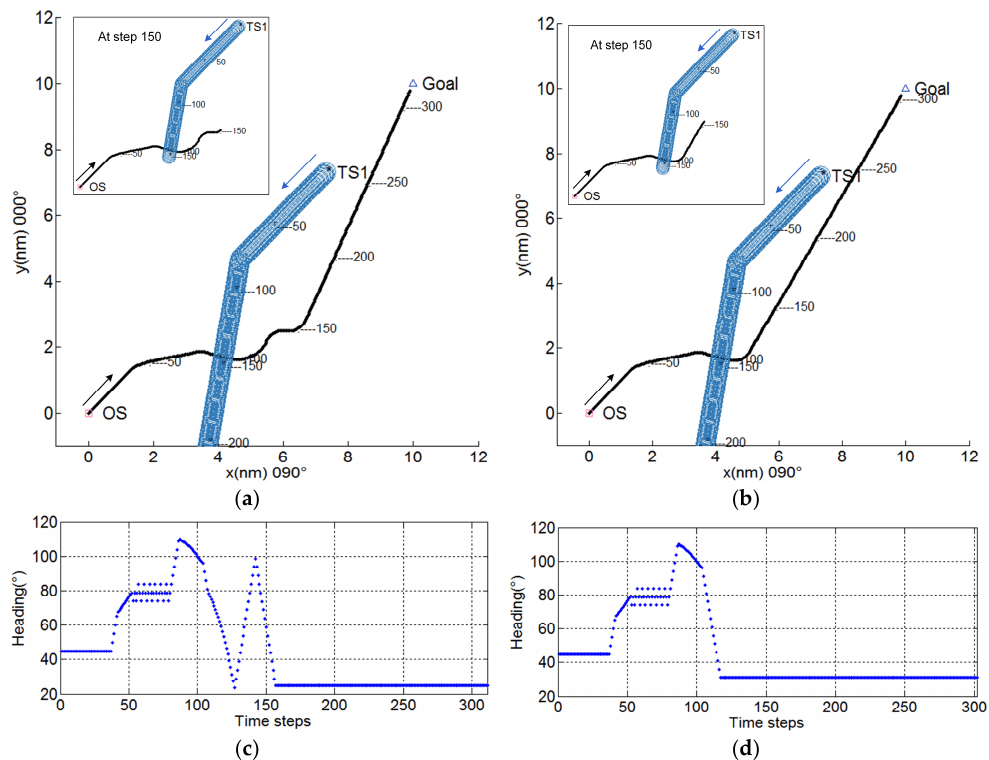
Figure 13. Comparison of the simulations for two methods regarding emergency scenarios. ( a ) and ( c ) show the simulation results before the improvement, where the own ship can alter course 33 ◦ to